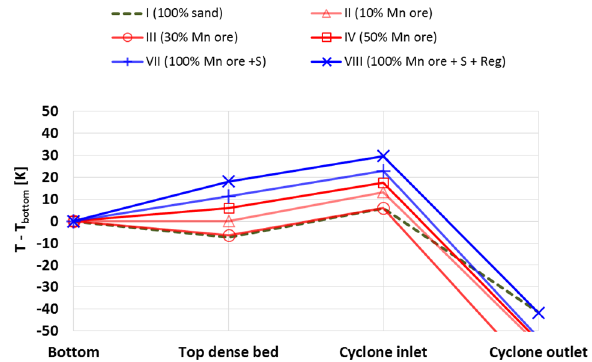
Figure 3. Temperature profile over the boiler when operated on lower air ‐ to ‐ fuel ‐ ratio ( ≈ 1.07). T bottom was in the range 866–877 °C and have been used as reference.